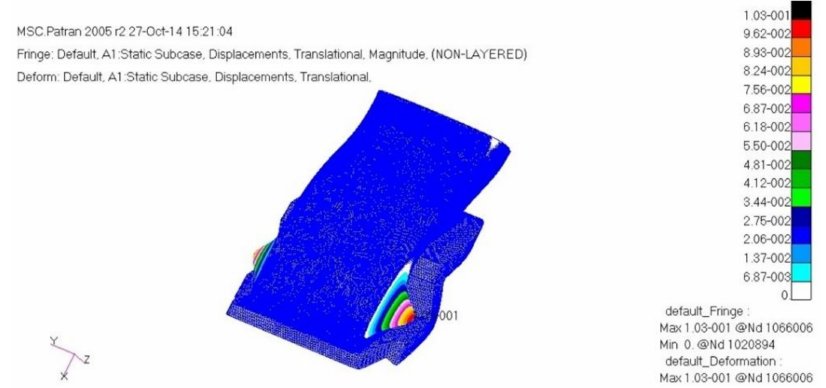
Figure 11. Displacement analysis